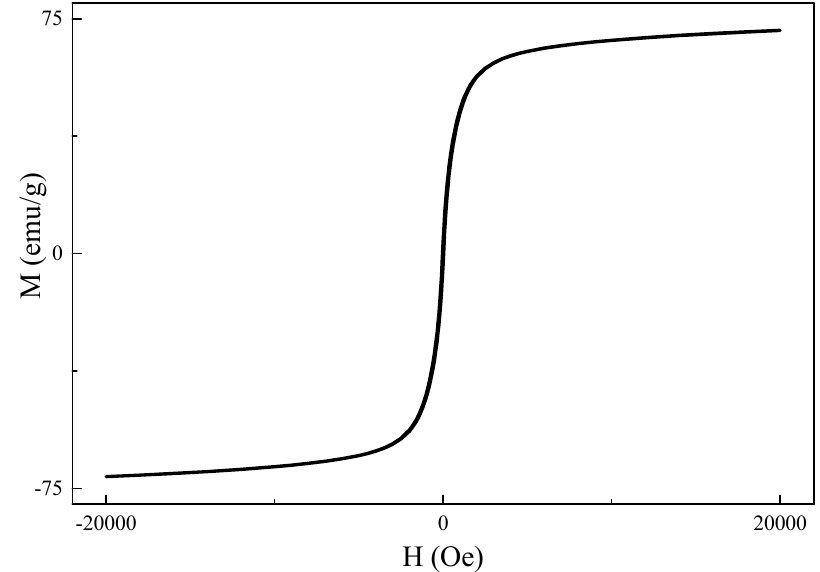
Figure 3. Magnetization (M) vs applied magnetic field (H) for surface-modified Fe 3 O 4 nanoparticles at 300 K.